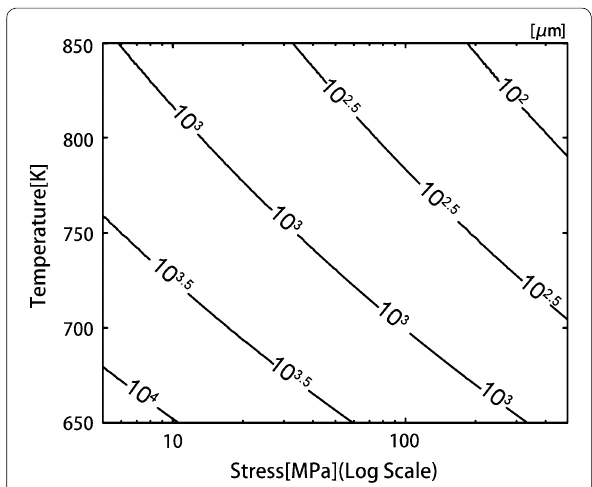
Fig. 2 Contours of equilibrium grain size as a function of tempera- ture and stress, assuming wet anorthite rheology